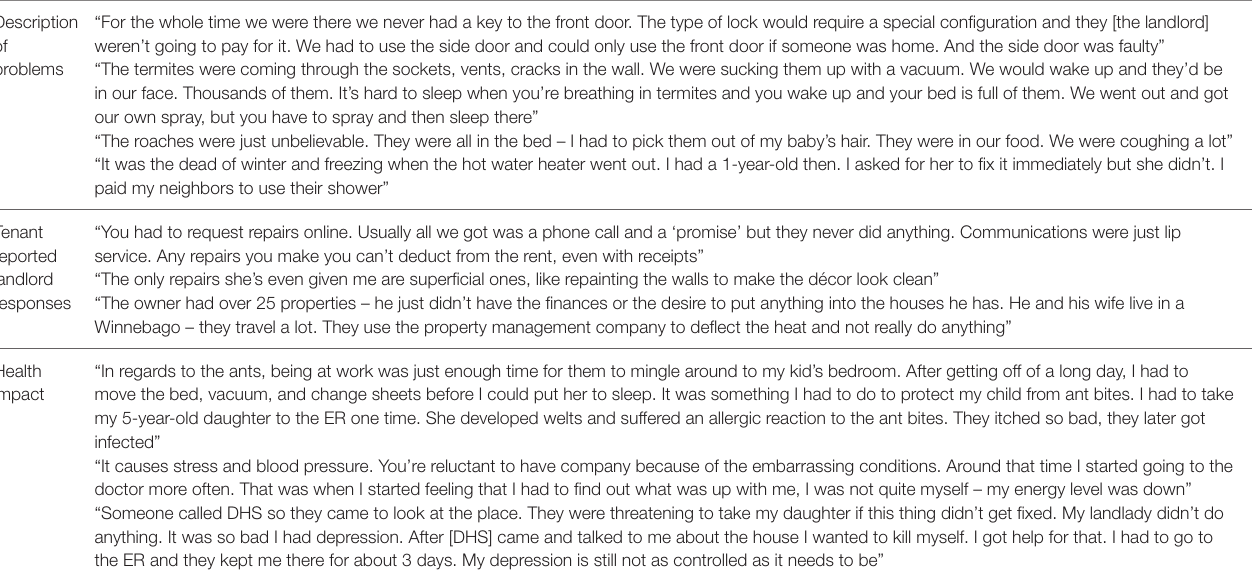
Table 3 | interview quotes illustrating description of problems, tenant reported landlord response, and health impacts.